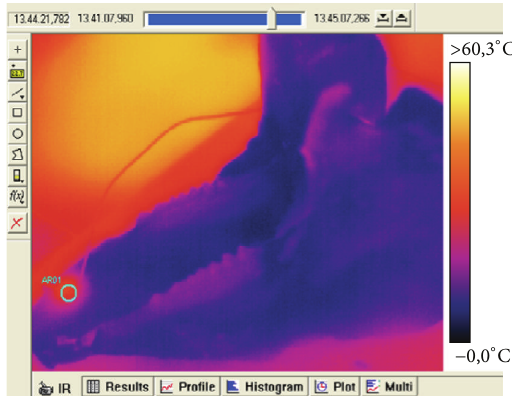
Figure 4: Thermal camera image of the specimen after treatment where the little blue circle defines the laser irradiated area.